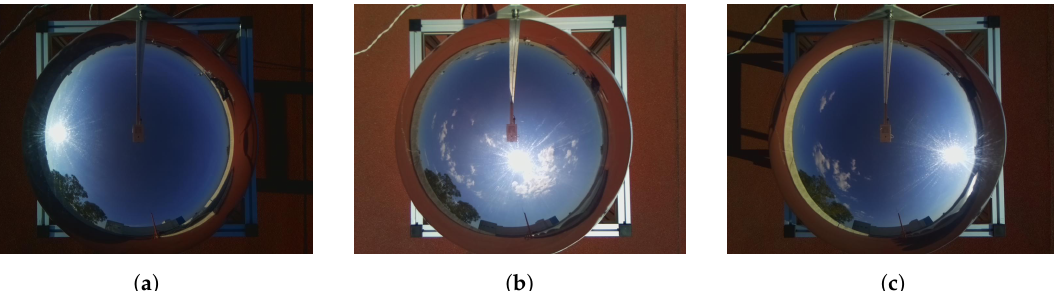
Figure 15. Representative examples where a partially sunny day is presented. ( a ) shows an image taken at 9:00, ( b ) shows an image taken at 14:30, and ( c ) shows an image taken at 18:00.